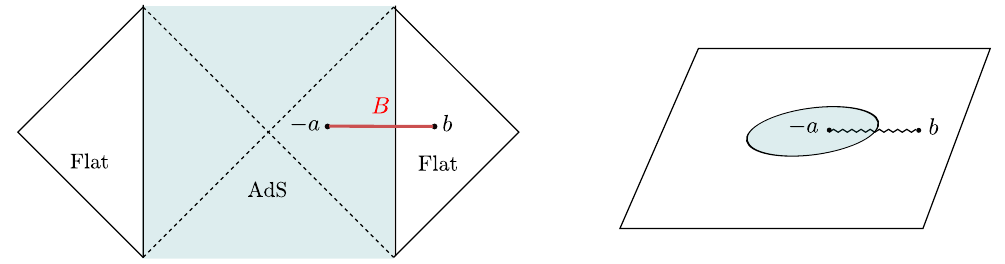
Figure 12 . The single interval con(cid:12)guration in Lorentzian signature (left) and in Euclidean signa- ture